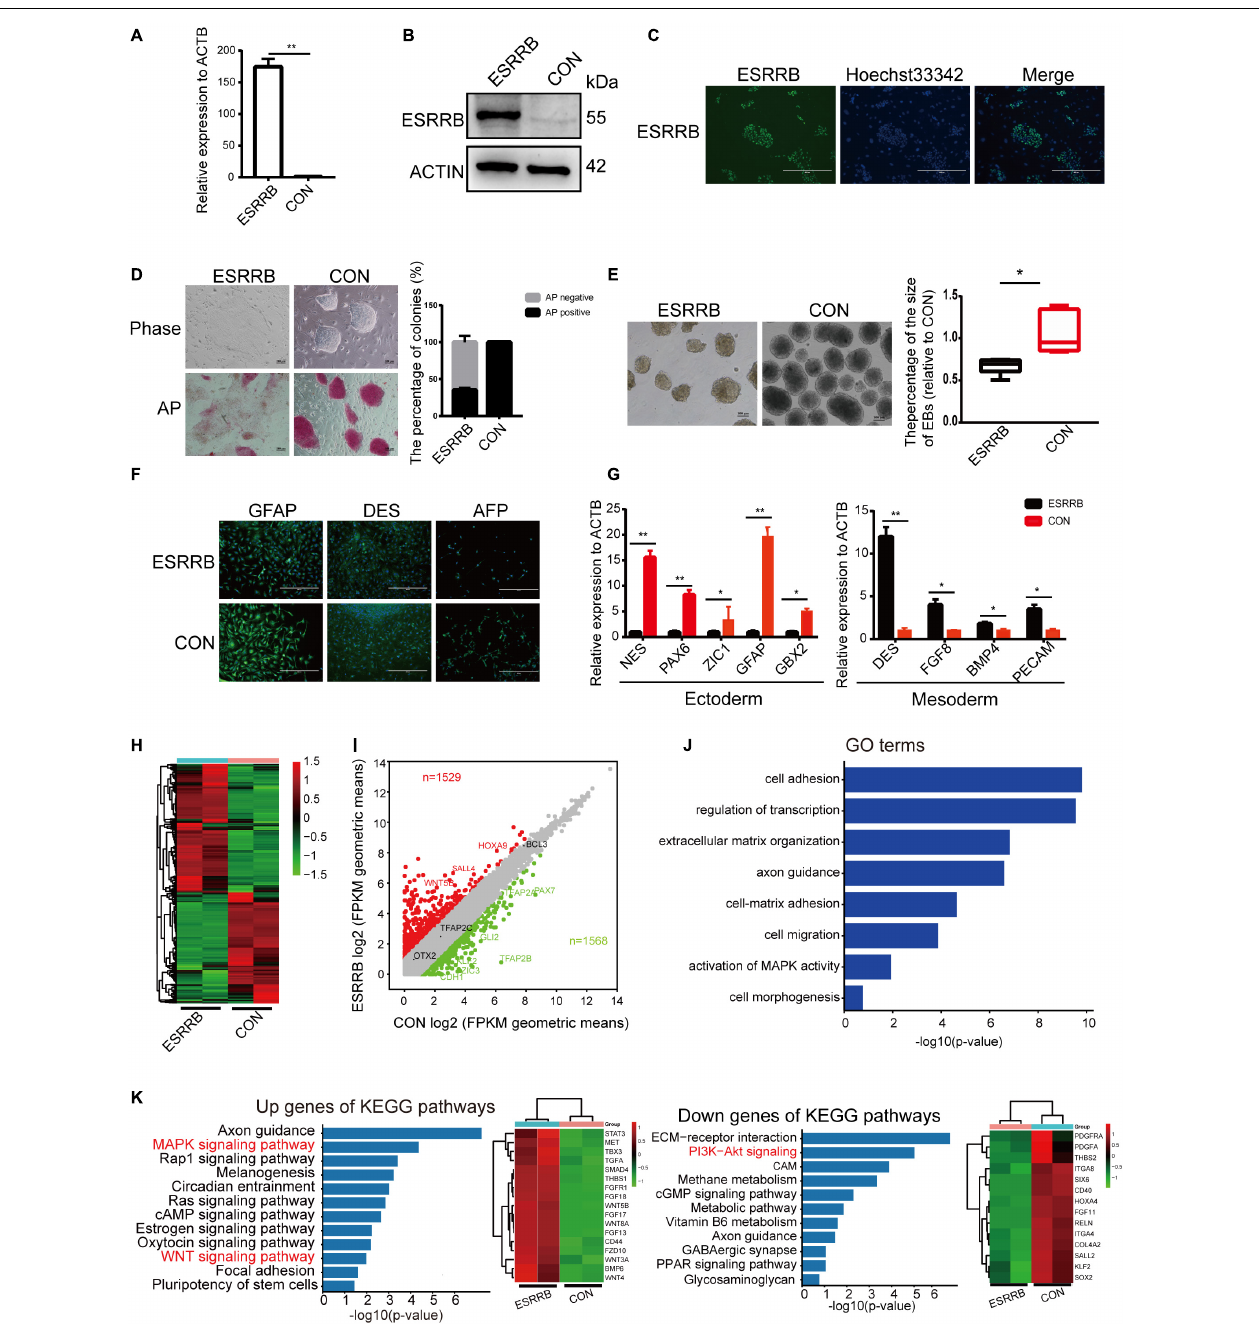
FIGURE 1 | Estrogen-related receptor beta (ESRRB) affected the self-renew and differentiation potential of porcine-induced pluripotent stem cells (piPSCs). (A) Quantitative RT (qRT)-PCR analysis of ESRRB in the control (CON) and ESRRB-piPSCs; ** p < 0.001. (B) Western blot analysis of the ESRRB level in the CON- and ESRRB-piPSCs. (C) Immunofluorescence analysis of ESRRB in the ESRRB piPSCs. The scale bar represents 400 µ m. (D) Representative image of bright field and alkaline phosphatase (AP) stained colonies in the control (CON) and ESRRB piPSCs. The scale bar represents 100 µ m. The quantitative analysis of AP-positive colonies is shown by histogram (the CON group was the control). (E) The embryoid body (EB) formation in the CON- and ESRRB-piPSCs. The scale bar represents 100 µ m. The quantitative analysis is shown by histogram. (F) The immunofluorescence staining of three germ layers in the CON- and ESRRB-piPSCs. The scale bar represents 400 µ m; (G) qRT-PCR analysis of three germ layers markers in the EBs derived from CON- and ESRRB-piPSCs; * p < 0.05 and ** p < 0.001. (H) The heatmap of CON- and ESRRB-piPSCs. (I) The volcano plot showing the number of up- or downregulated differentially expressed (DE) genes in the CON- and ESRRB-piPSCs detected by RNA-seq analysis. n = 2 independent experiments. (J) The Gene Ontology (GO) enrichment terms of biological process in the CON- and ESRRB-piPSCs. (K) the KEGG enrichment for up- and downregulated genes in the CON- and ESRRB-piPSCs; the right heatmap was the genes enriched into the signaling